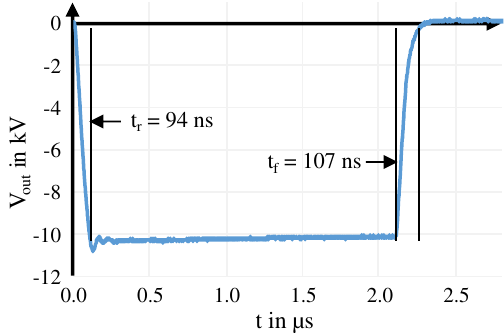
FIG. 5. Typical B - H curve of a nanocrystalline material. B r is the remnant flux-density and B is the saturation flux-density of FIG. 6. Measured output voltage pulse, for the ten-layer small- sat the material. scale prototype with two branches per layer, across a 50 Ω